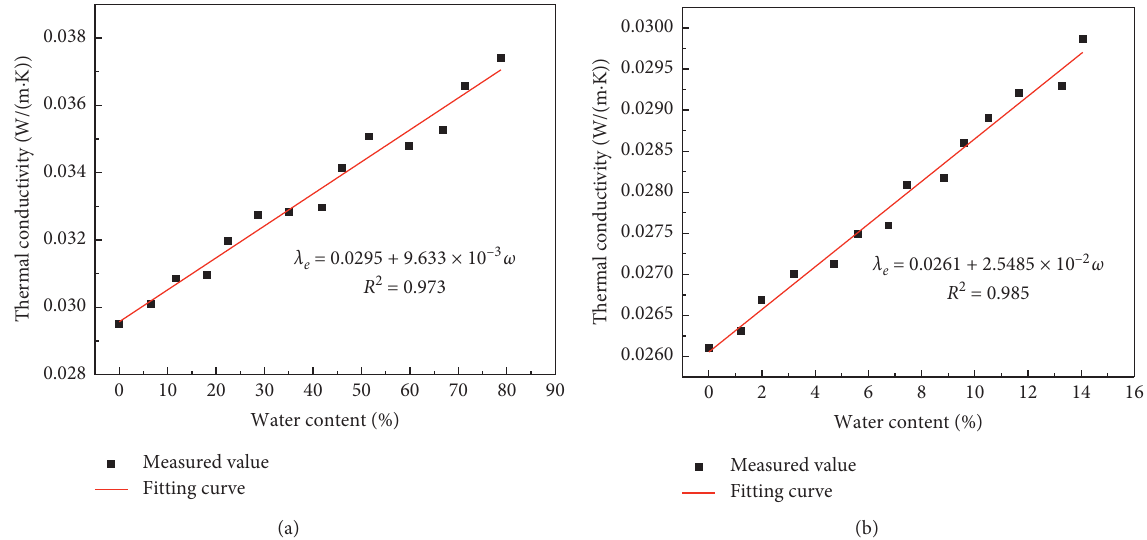
Figure 10: Relationships between the thermal conductivity and water content of polyphenolic and polyurethane insulation boards at room temperature. (a) Polyphenolic. (b) Polyurethane.